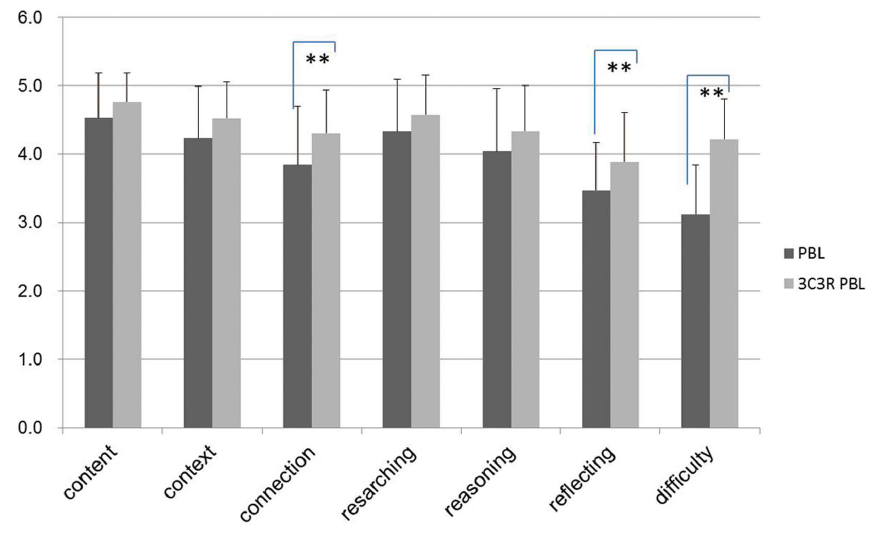
Figure 2. Comparison of test scores from students for 3C3R-PBL and PBL.